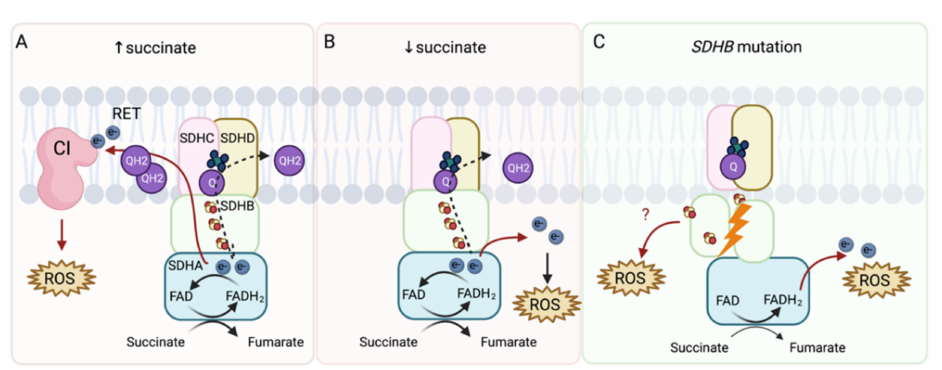
Figure 2. ROS production from SDH under physiological and pathophysiological conditions. The SDHA subunit covalently binds flavin adenine dinucleotide (FAD), which removes electrons from succinate to form fumarate. SDHB then transfers electrons via three iron–sulfur (FeS) clusters to the ubiquinone molecule (Q) located in the ubiquinone-binding site, formed by the SDHB, SDHC, and SDHD subunit. Ubiquinone is further reduced to ubiquinol, fueling CIII and CIV (dashed arrow). ( A ) At high succinate concentrations ( ≥ 5 mM), succinate-derived electrons reduce the ubiquinone pool and electrons are forced backward to CI in a process called reverse electron transfer (RET), which leads to indirect ROS production. ( B ) At physiological succinate concentrations, ROS can be produced directly. FAD is reduced to FADH2, which then reacts with oxygen within an unoccupied binding site to form ROS. ( C ) In cases of SDHB mutation, incorrect assembly of SDH can result in ROS production directly from reactions between oxygen and FADH2 or exposed FeS